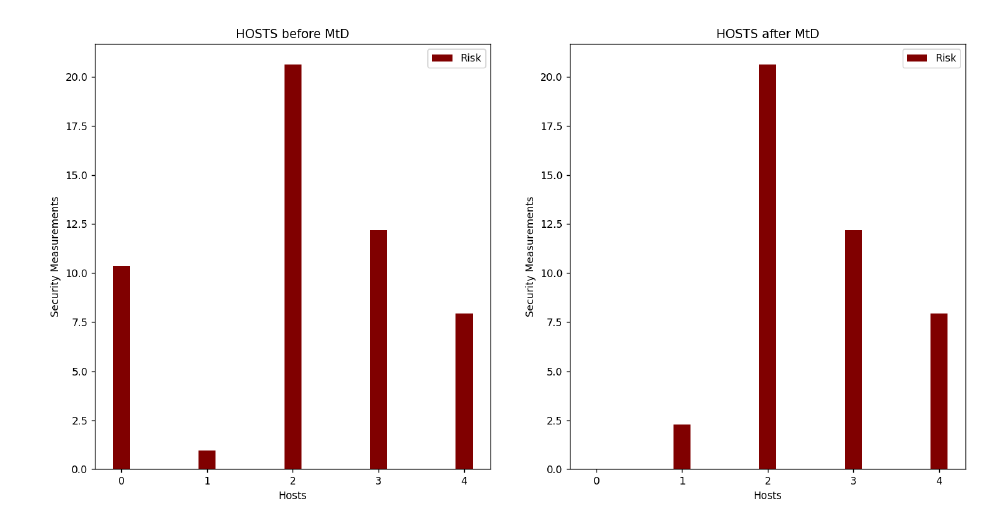
Figure 8. Comparison of security metrics of hosts before and after applying shuffle and diversity MtD.